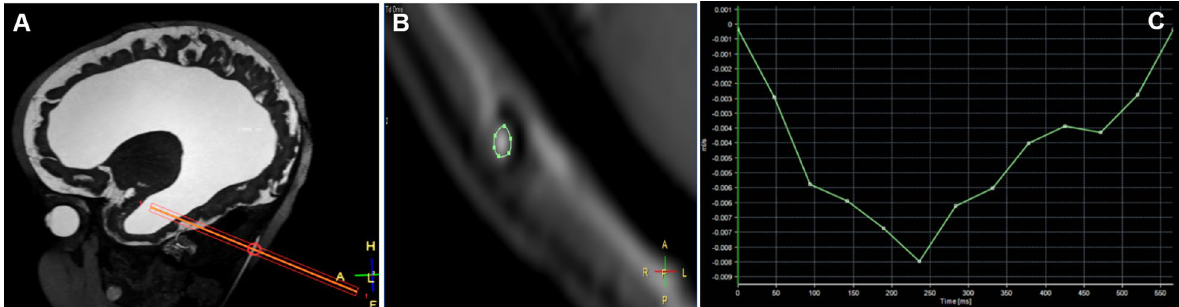
Fig. 1 ( A , reconstructed 3D‑DRIVE in sagittal plane) ECG‑gated quantitative PC was acquired perpendicular to the long axis of the shunt catheter at the suboccipital region distal to its valve. B A ROI was drawn over the inner diameter of the shunt tube in axial re‑phased image. C CSF flow curve and velocity parameters were calculated by CSF‑QF